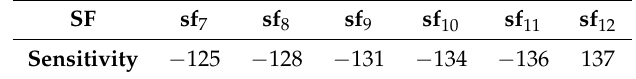
Table 3. Sensitivity for different Spreading Factor (SF) values and a bandwidth of 125